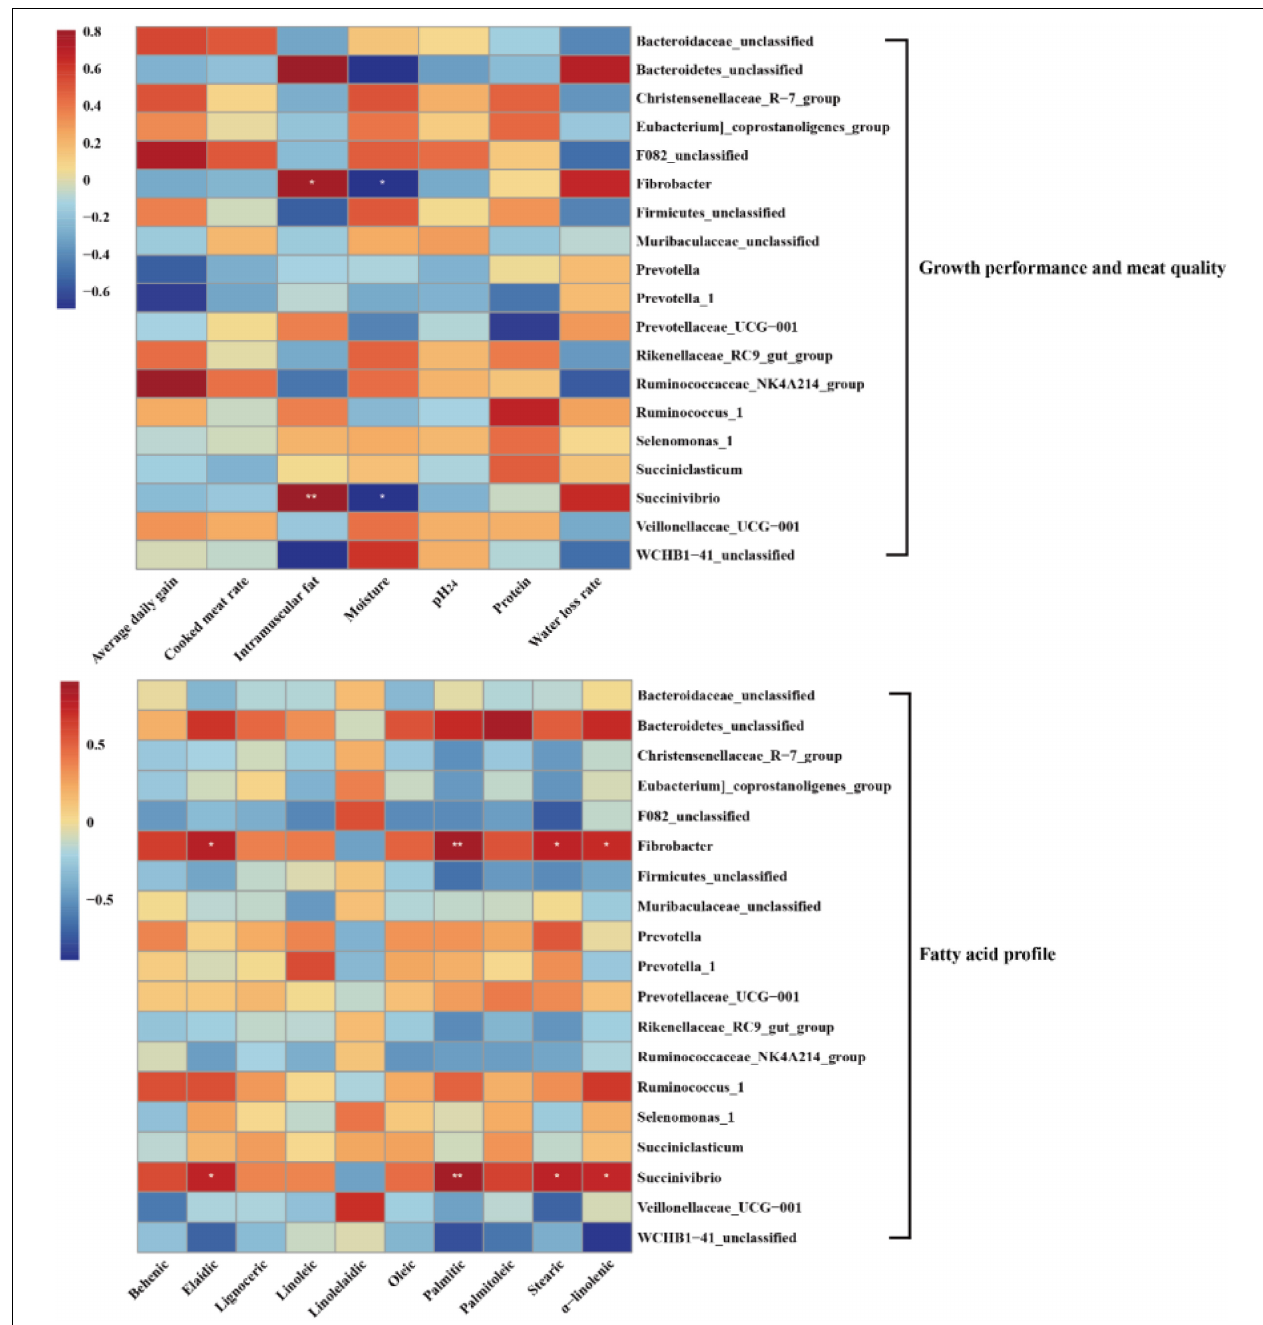
FIGURE 5 | Heatmaps of Pearson’s correlations between dominant genera and growth performance, meat quality, and fatty acid profile. Red represents a positive correlation, while blue represents a negative correlation. Levels of significance are shown as follows: * P < 0.05; ** P <